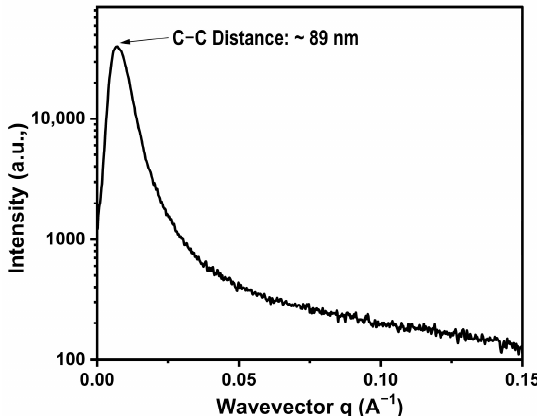
Figure 4. SAXS profile of the highly crosslinked 4 NRM 50 semi-IPN.